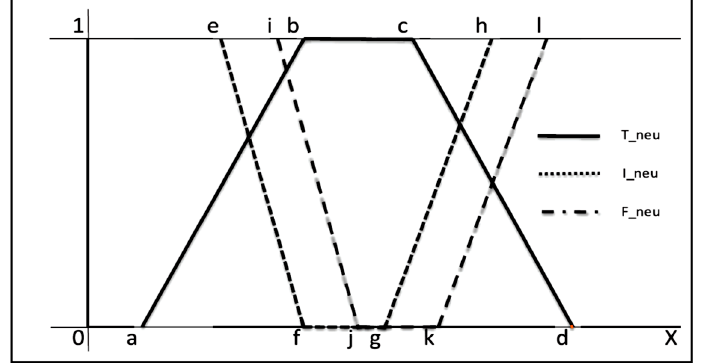
Figure 7. Linear trapezoidal neutrosophic number.